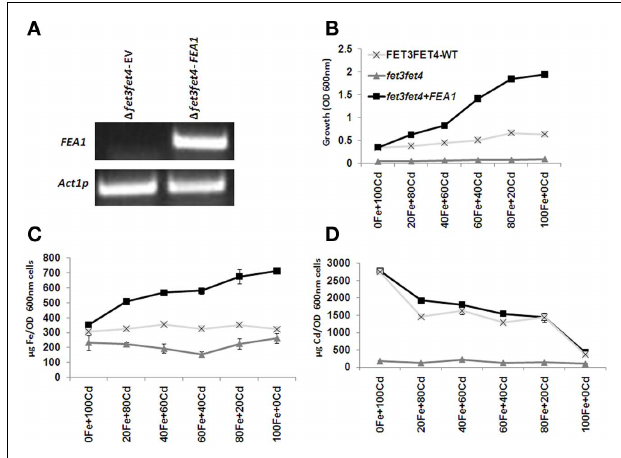
FIGURE 10 | FEA1 does not transport cadmium in transgenic yeast. (A) RT-PCR analysis of FEA1 expression in Δ fet3fet4 mutant yeast cells transformed with pYES2: FEA1 . Actin expression was used as an internal control. (B) Growth rates of wild-type, iron uptake mutants ( Δ fet3fet4) , and mutants complemented with pYES2: FEA1 . Cell were grown in SC-URA medium containing 2% (w/v) galactose with various amounts ( μ M) of cadmium and iron (C) ICP-MS analysis of iron concentrations normalized for cell number. (D) ICP analysis of cadmium concentrations normalized for cell number. Data are means + SE of three replicate